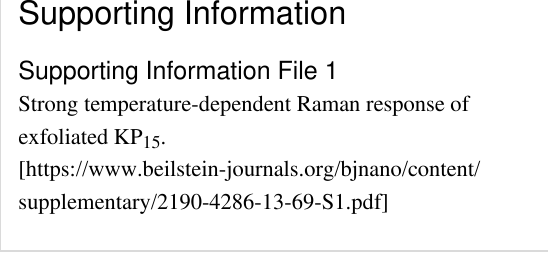
nesses of 79% of liquid-exfoliated KP 15 nanowires were below 50 nm and the widths of 60.9% of KP 15 nanowires were below 100 nm. Meanwhile, a strong temperature-dependent Raman response has been found in exfoliated KP 15 , which may help with non-invasive temperature measurements of KP 15 nanode-